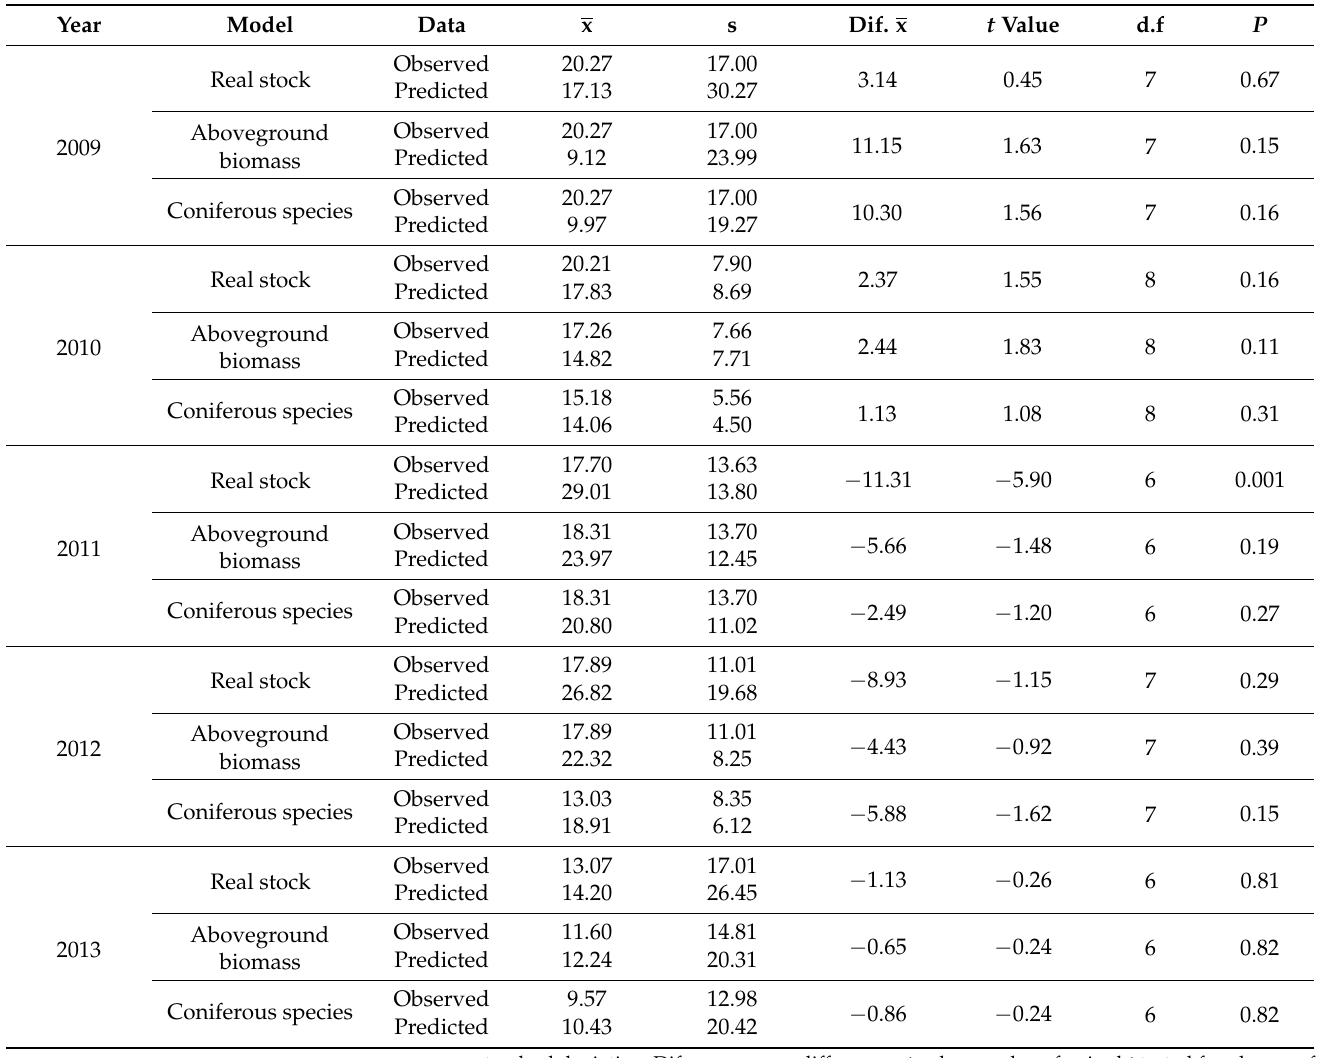
Table 4. Analyses of validation results for 25% of the conglomerates in the three prediction models by